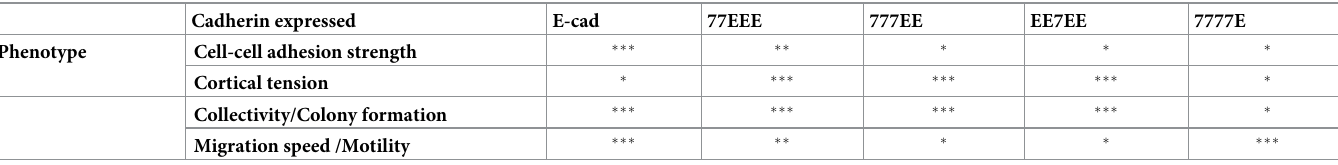
Table 2. Summary of results. Cadherin